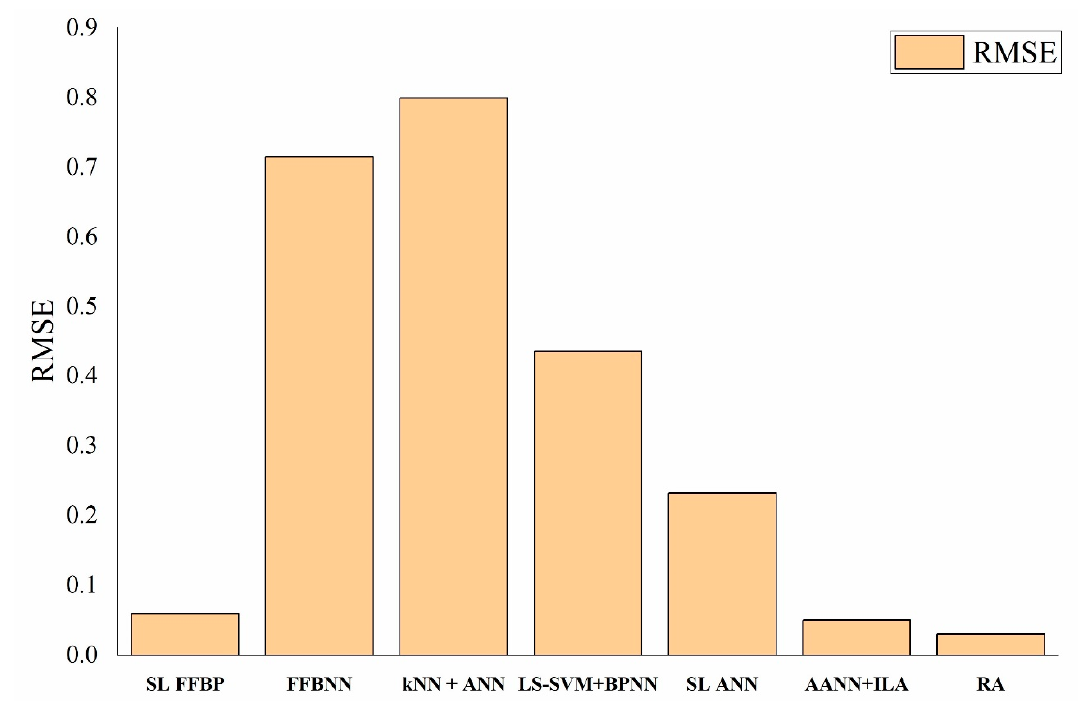
Figure 9. The bar chart shows the root mean square error (RMSE) of few LARA models. For simplicity, the accuracy value of AANN + ILA [12], and RA [13] was considered as the 0.05 and 0.03 RMSE value, respectively. Besides, we could not plot SML [6], and BPNN [8] due to data unavailability, and FFMLP + SL [9] due to data mismatch. Further, if there exists a range of RMSE values (Table 5), we considered the maximum RMSE for such cases.